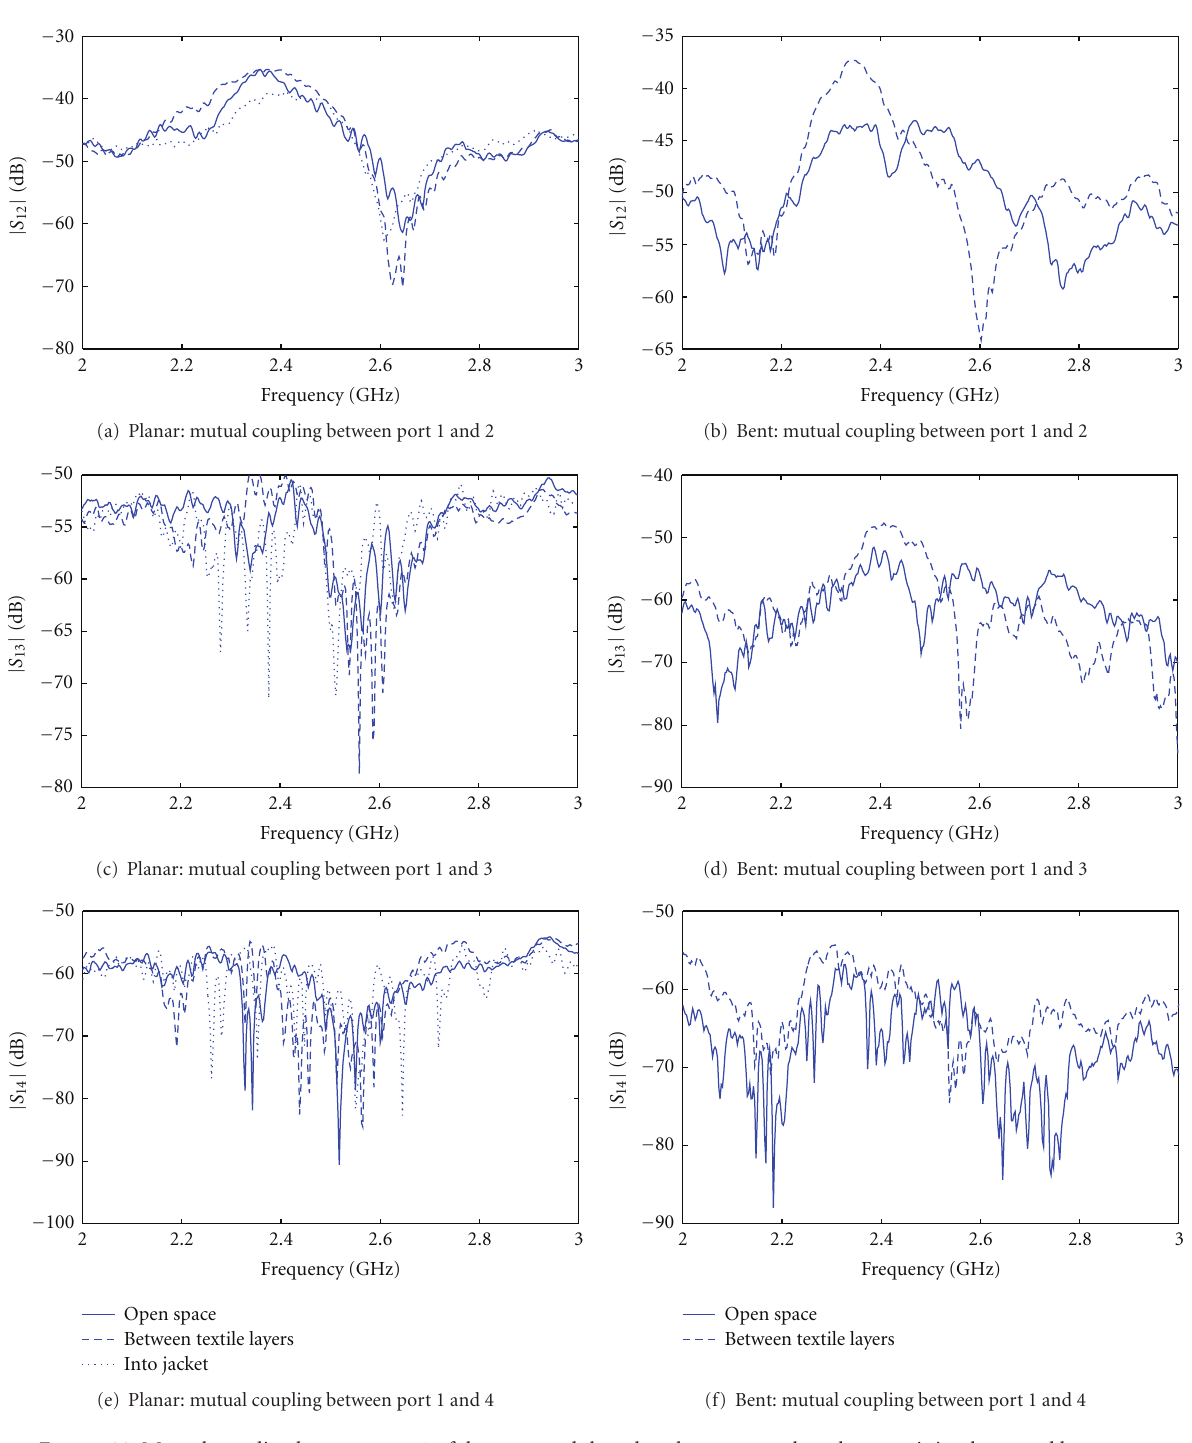
Figure 22: Mutual coupling between port 1 of the array and the other three ports, when the array is in planar and bent